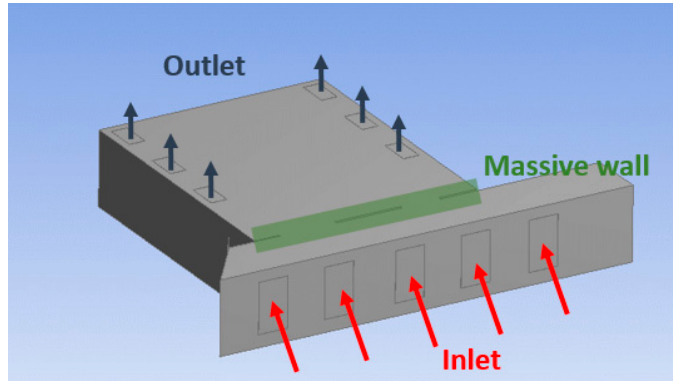
Figure 10. Ventilation strategy model for one floor of the building.